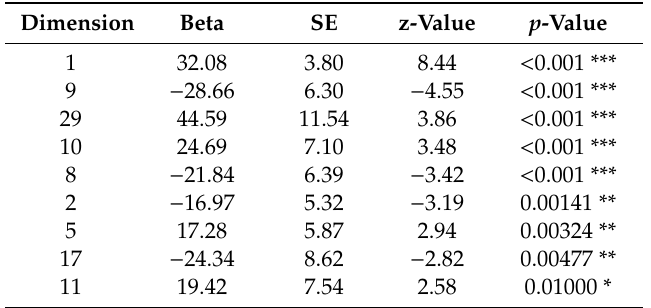
Table 2. Values of significant dimensions in multiple component analysis (MCA). Dimension Beta SE z-Value p